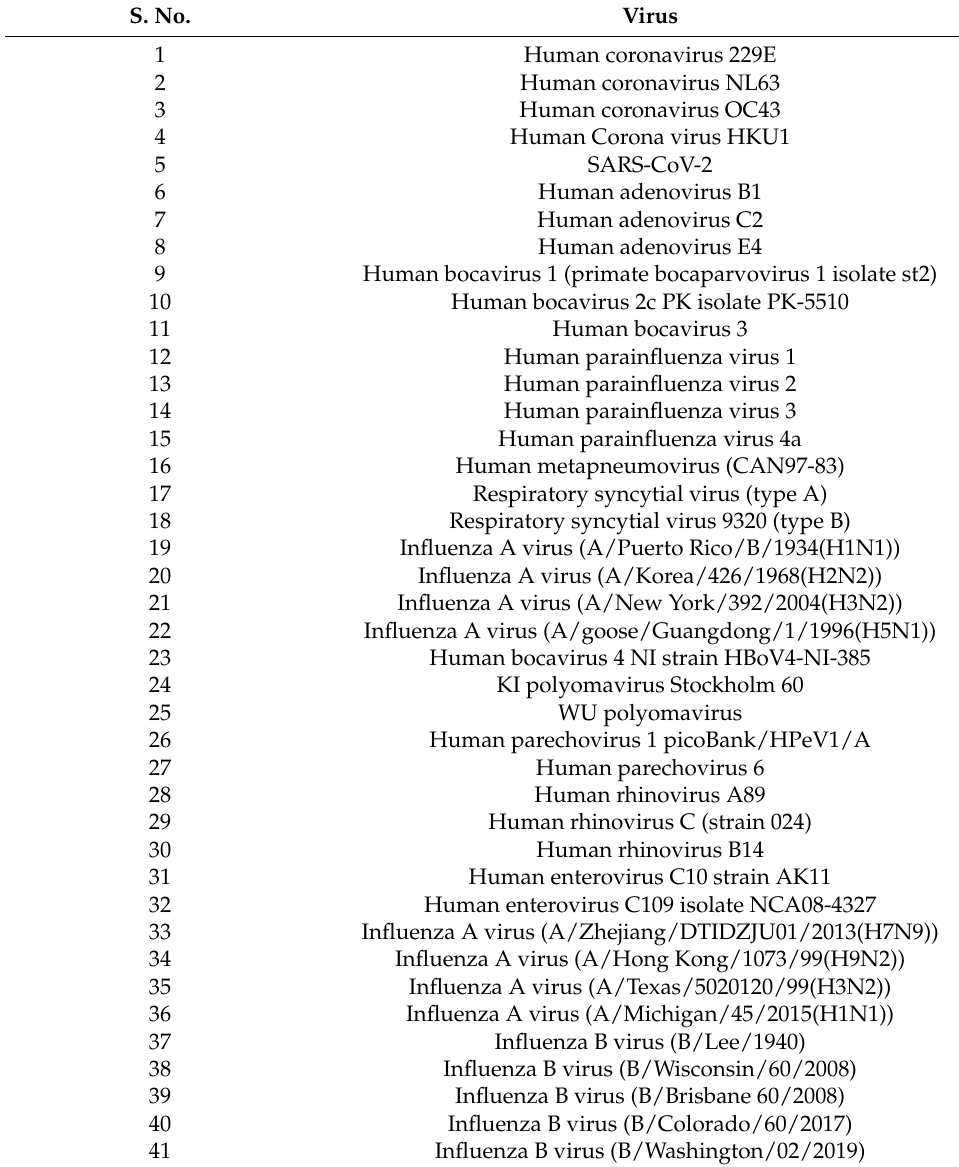
Table 1. Table showing the viruses included in the enrichment workflow of the Respiratory Virus Oligos Panel